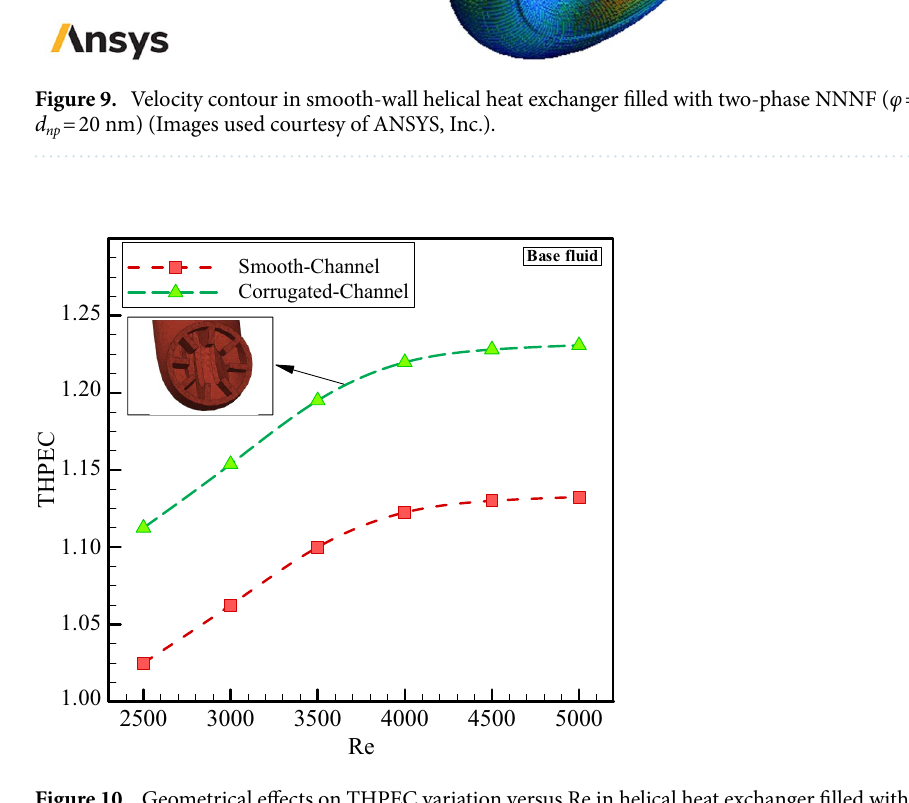
Figure 9 represents velocity contour in smooth-wall helical heat exchanger filled with two-phase NNNF ( φ = 1% and d np = 20 nm).